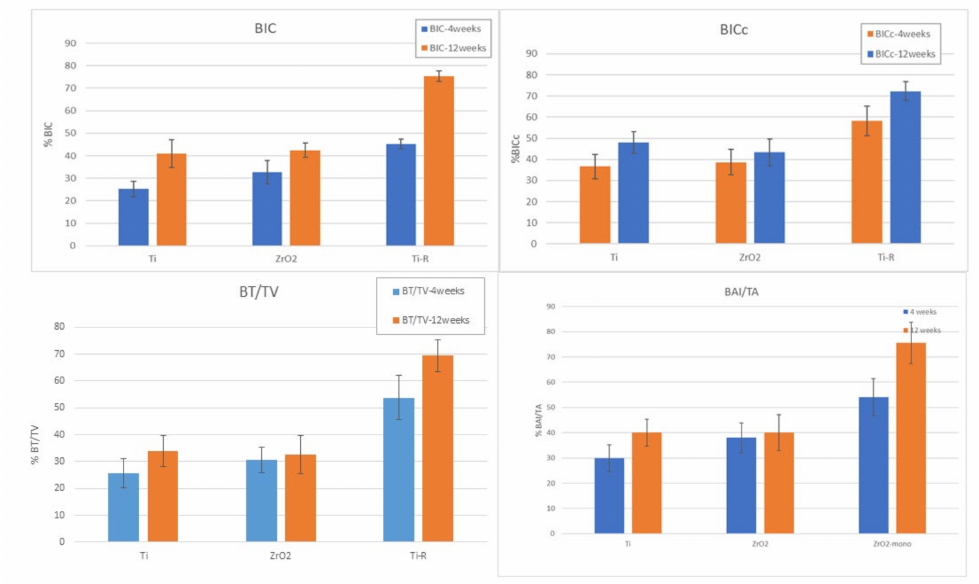
Figure 6. BIC, BICc, BT/TV, BAI/TA results for each dental implant and for different times of